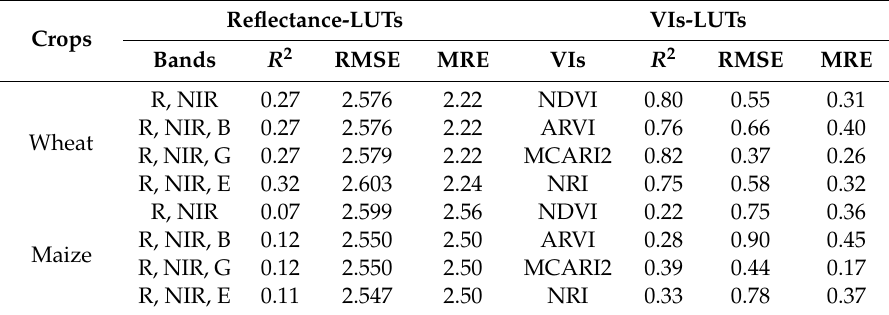
Table A2. LAI retrieval accuracy ( R 2 , RMSE, and MRE) based on reflectance-LUTs / VIs-LUTs using hyperspectral UAV data in 2018 (n =